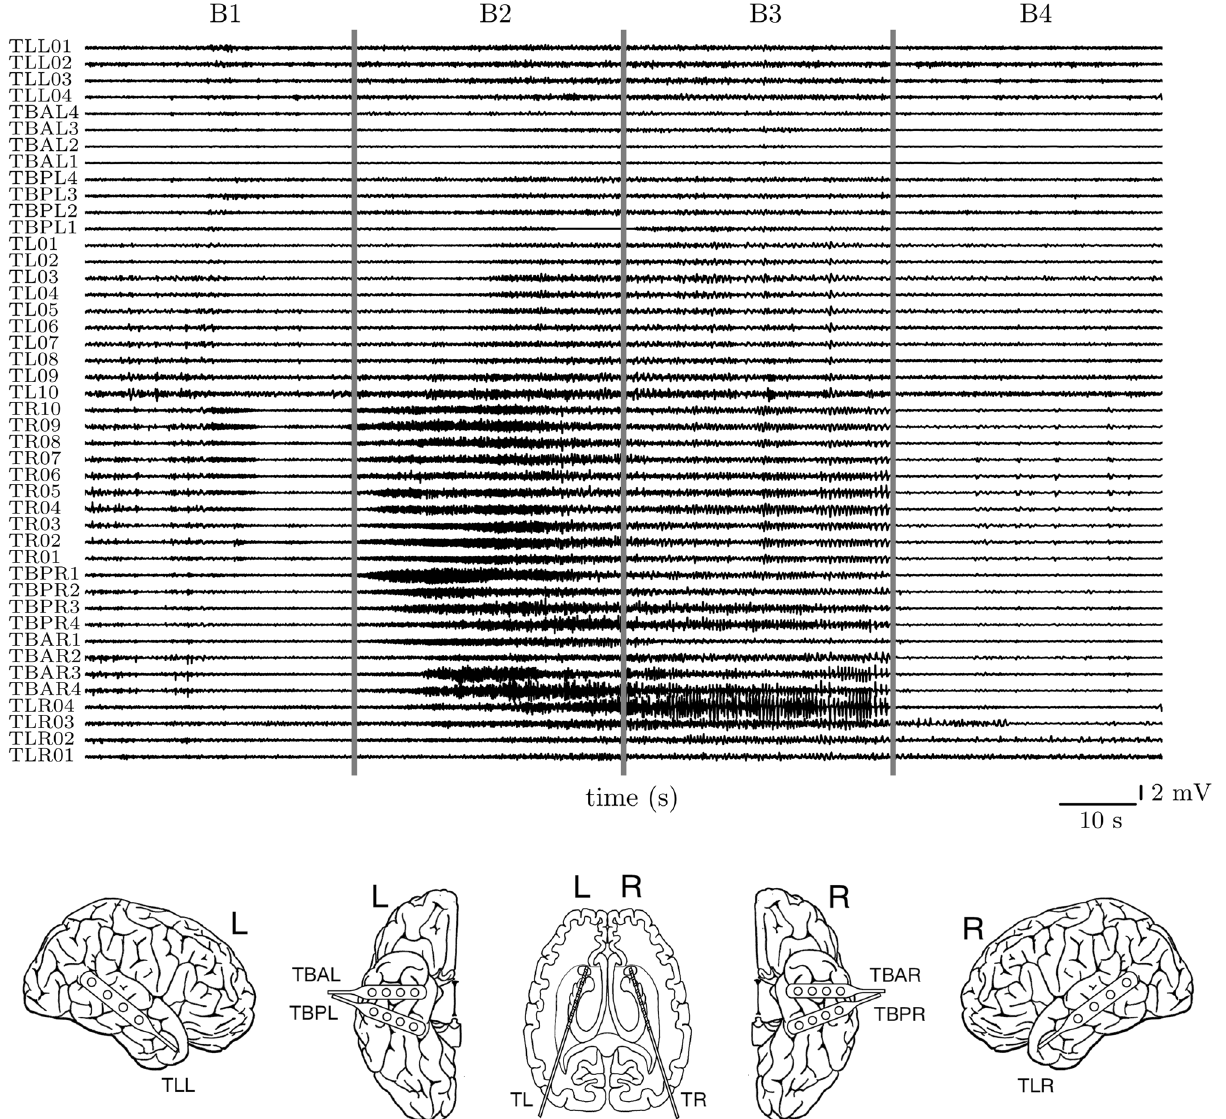
phase; blocks B2 and B3 indicate the first and second half of the seizure (electroencephalographic seizure onset and ending determined automatically 70 ); block B4 indicates the post-seizure phase. Bottom: schematics of sensors placed over the left and right temporal-lateral and temporal-basal neocortex and of bilateral intrahippocampal